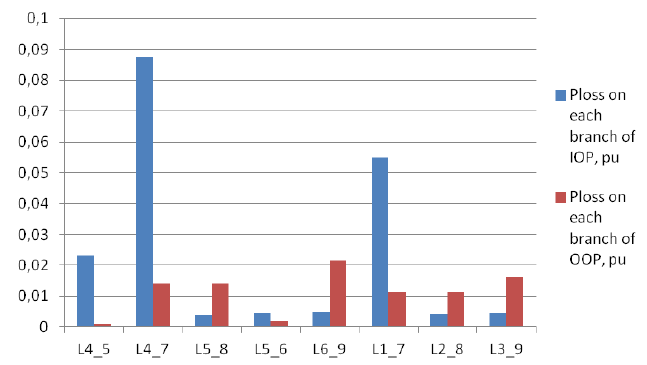
Figure 5. Power losses in each branch before (IOP) and after (OOP) the optimization.